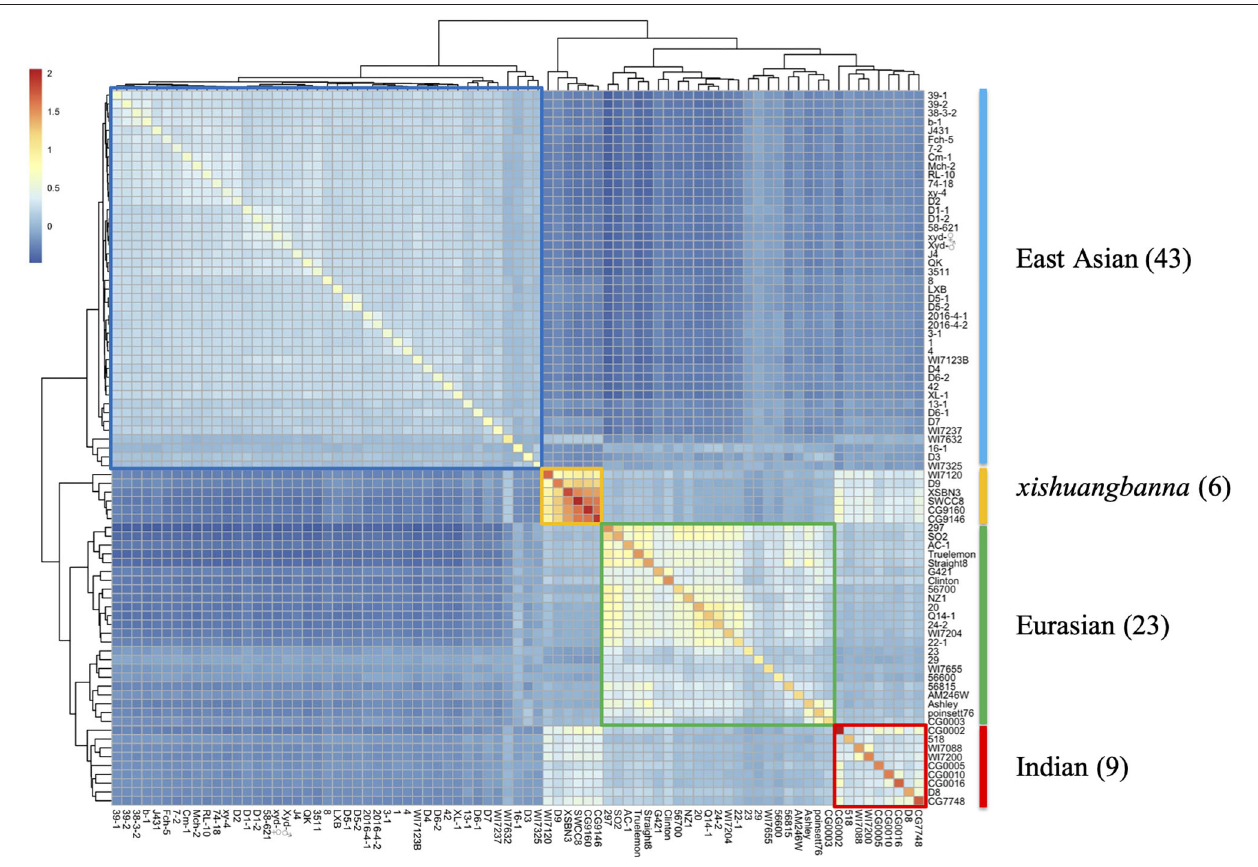
FIGURE 2 | The heat map of the G A matrix for the dataset with 81 cucumber inbred lines genotyped with 16,662 SNP markers. All 81 cucumber lines are clustered into four groups, namely, East Asia, Eurasian, Indian, and xishuangbanna groups,